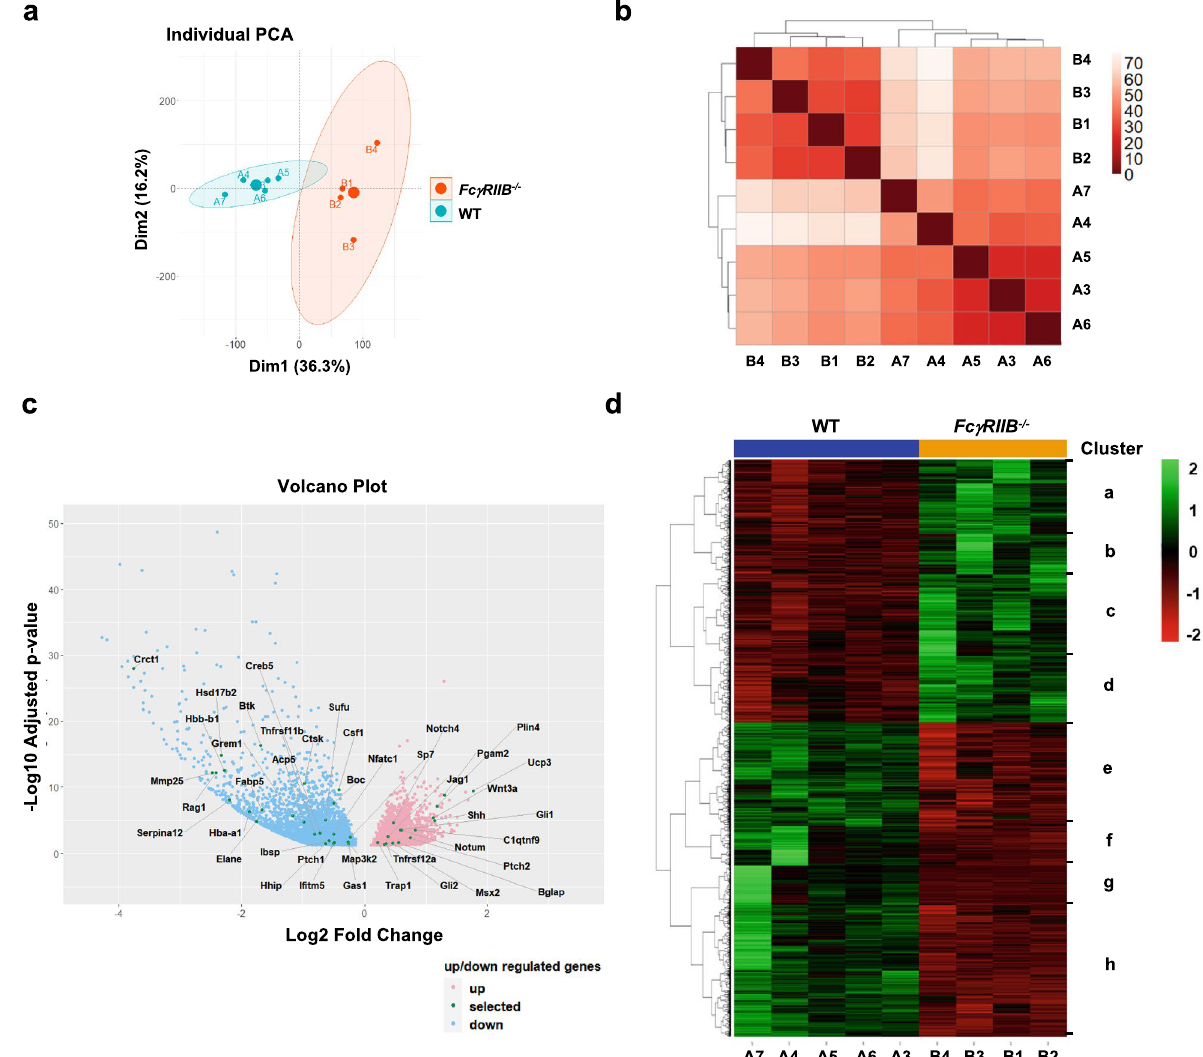
Figure 2. Transcriptional profiling identified differential gene expression in bone cells from WT and FcγRIIB -/- mice. ( a ) PCA analysis of DEGs. The percentage variation for each dimension (Dim) are indicated in bracket on horizontal and vertical axis. ( b ) Sample-to-sample distance based on similarity of their gene expression profiles identified by Spearman’s rank correlation between samples. The shorter the distance, the more closely related the samples are. ( c ) Volcano plot of DEGs. Red dots represent significantly upregulated genes ( n = 2,710) and blue dots represent significantly downregulated DEGs ( n = 3,252) compared to WT controls. ( d ) Hierarchical clustering heatmap of DEGs across two comparisons. Green represents high gene expression and red represents low gene expression. Color descending from green to red indicates the z-score of log2 fold change (log2 FC) from high to low